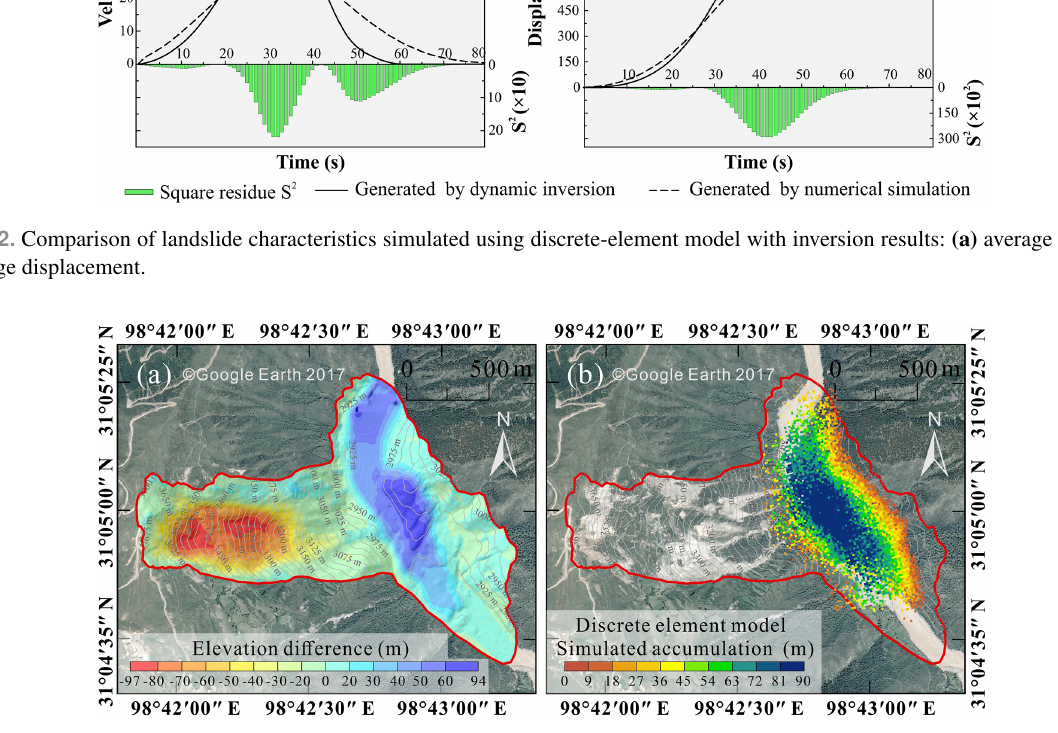
Figure 13. Comparison of elevation change associated with the Baige landslide (a) estimated from pre- and post-failure topography and (b) calculated using the discrete-element model. The remote sensing image map data of (a) and (b) are from the © Google Earth 2017.